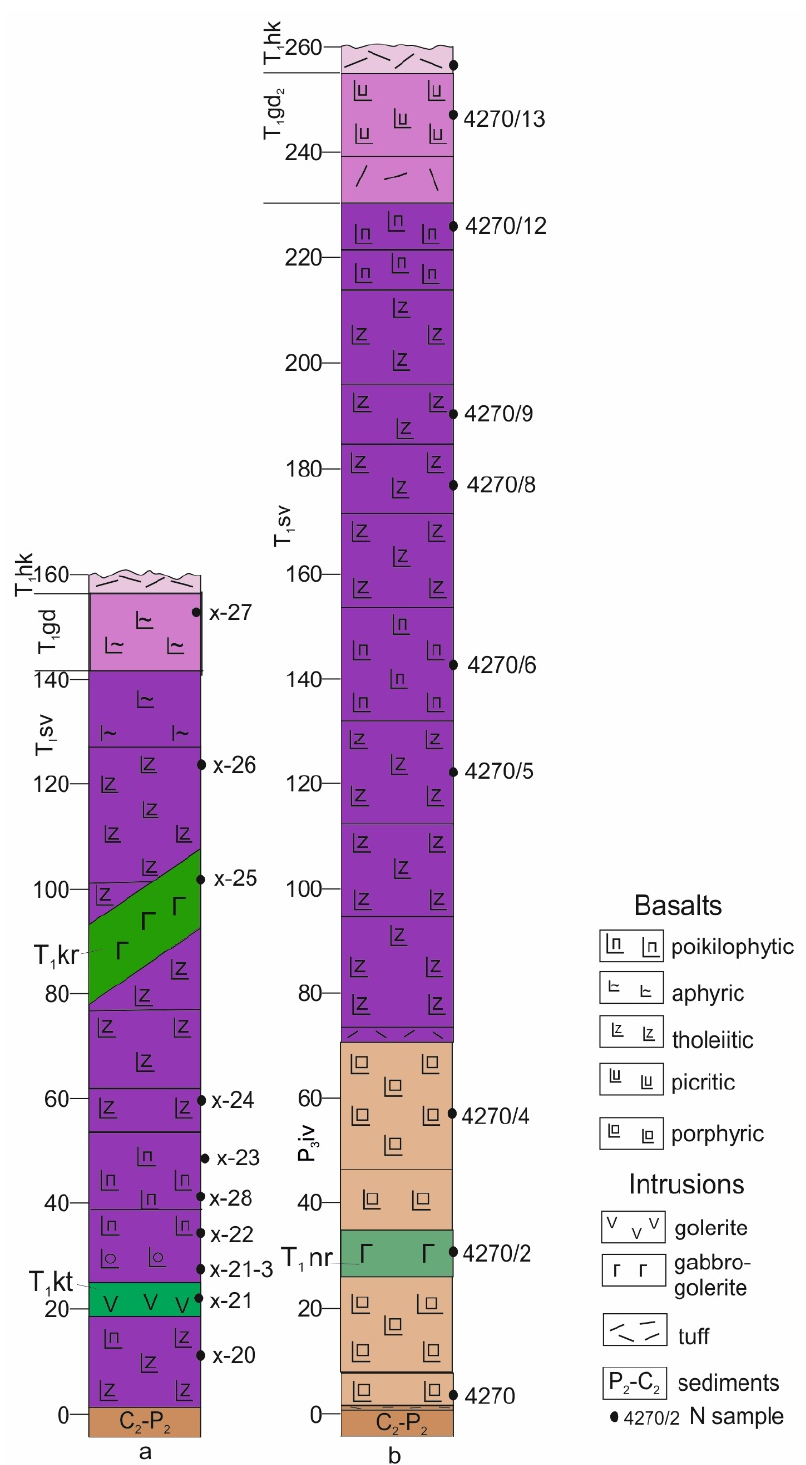
Figure 6. Sections of volcanic rocks in the Khalil area ( a , Section 1) and the eastern Norilsk area ( b , Section 2 shown in Figure 1 and in [58]).